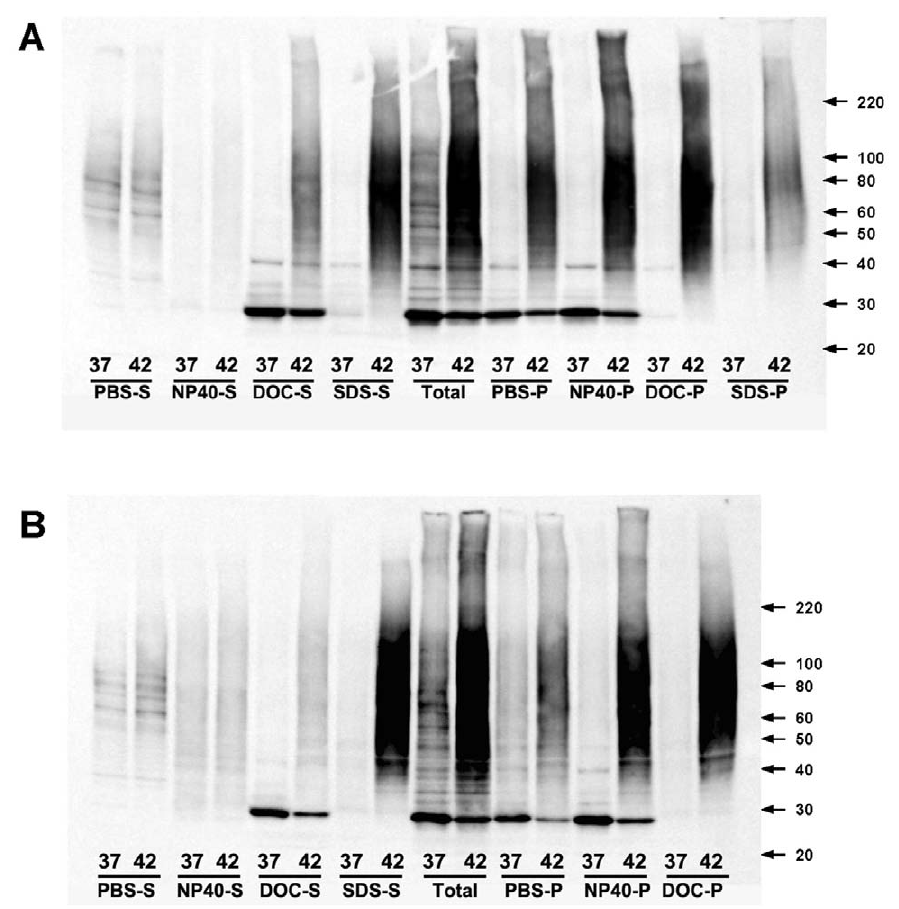
Figure 2. Accumulation of detergent-insoluble ubiquitinated proteins in heat-shocked SH-SY5Y (A) and STTG1 (B) cells. Immunoblot of cell fractions with antibodies to ubiquitin [1:5000, (monoclonal 5–25, Signet, Covance Inc.)]. The image shown is representative of 3 repetitions of the experiment.